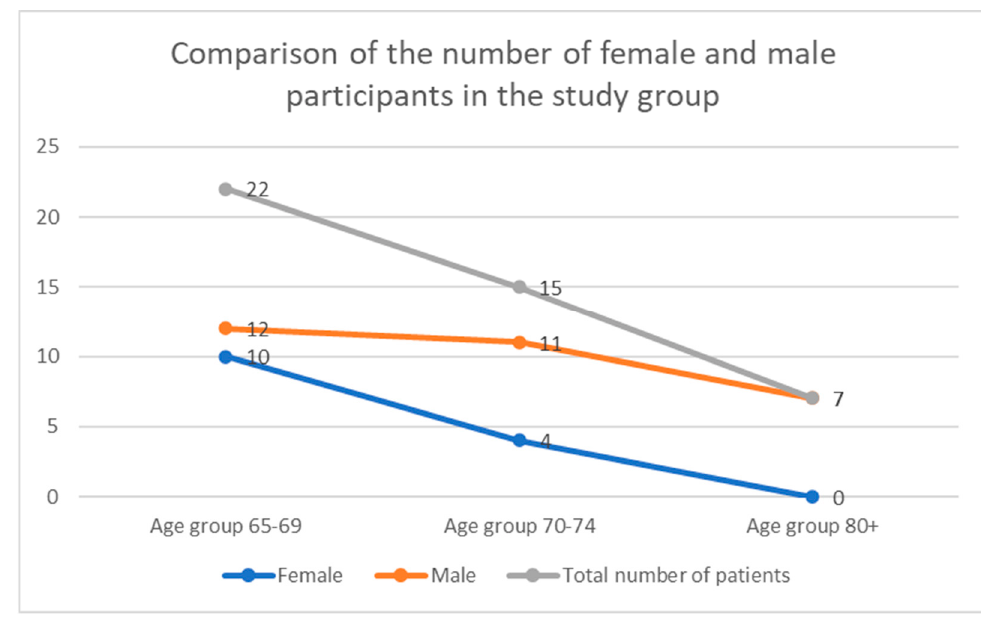
Figure 9. The number of female and male participants in our study group.